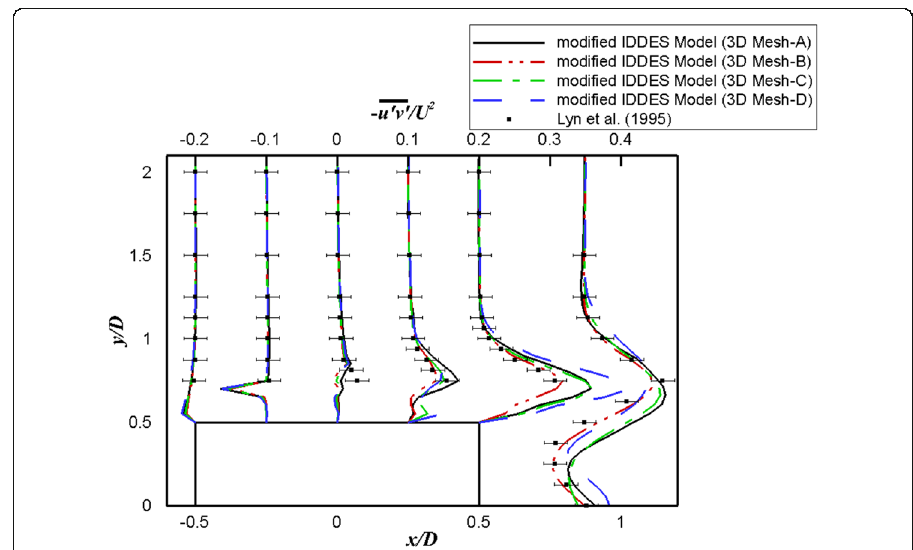
Fig. 15 Reynolds-averaged shear stress profile at different locations before wake predicted by 3D simulations with the modified IDDES